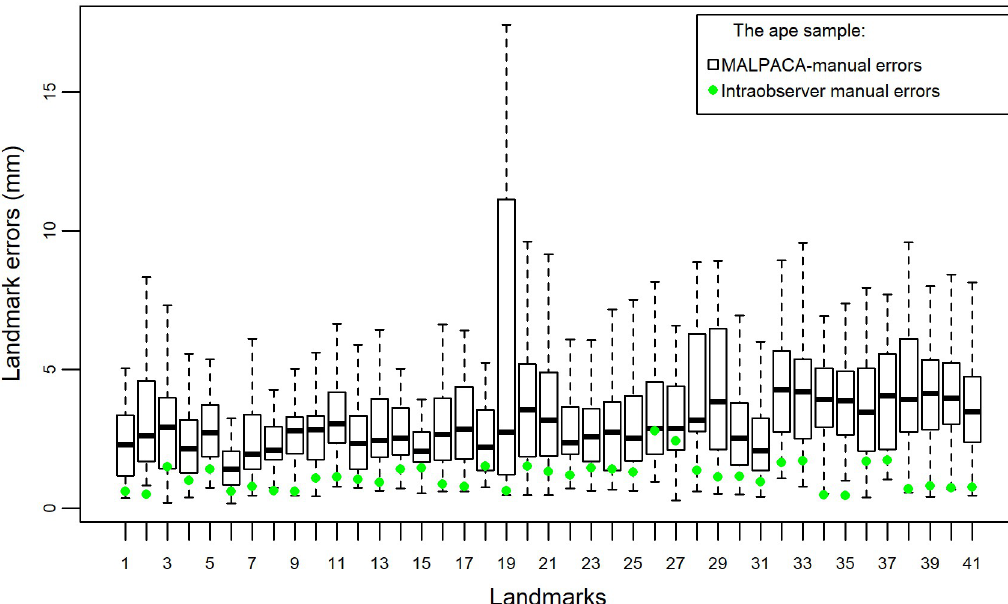
Fig 8. Individual landmark errors of the ape sample. Errors represented by Euclidean distances (for errors expressed in percentage of centroid sizes, see S3 Fig). Each column represents errors between MALPACA-derived estimates of all 46 ape specimens for the one landmark and their corresponding Gold Standard (GS) landmarks. Each green dot represents the median of the intraobserver manual errors of all 46 ape specimens for one landmark between two manual landmark sets.